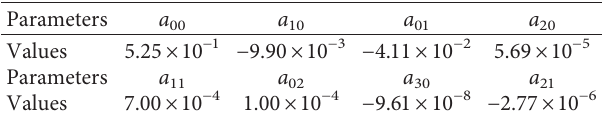
Table 3: The parameters of k ∗